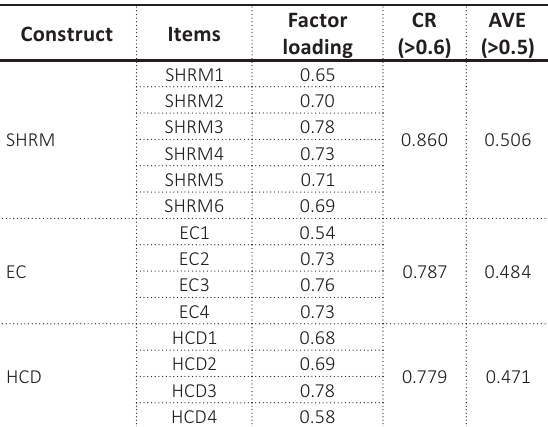
Table 5. AVE and CR for pooled CFA